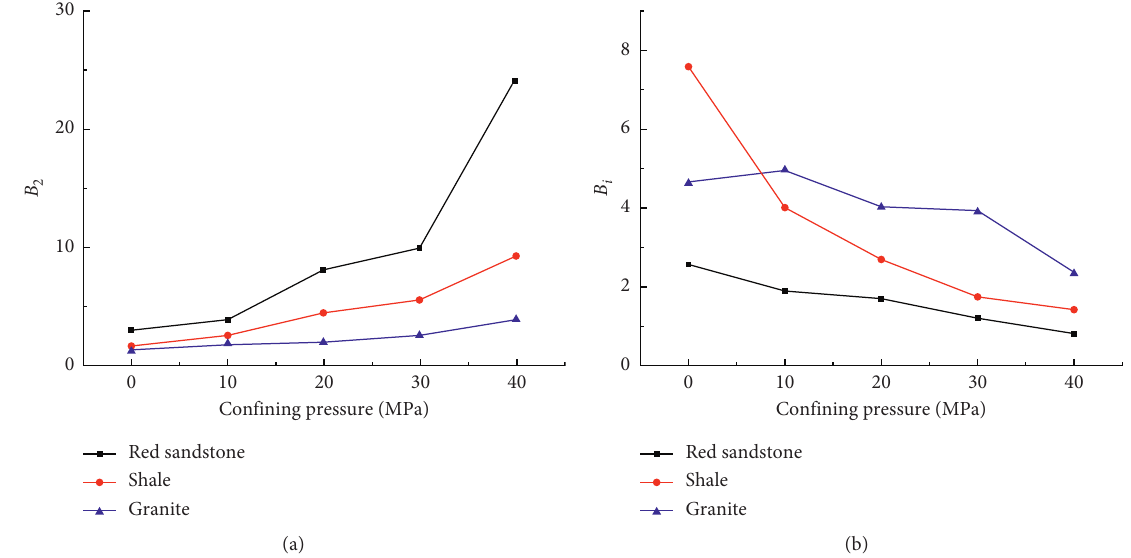
Figure 5: Brittleness order of the materials under different confining pressure in different index systems: (a) B